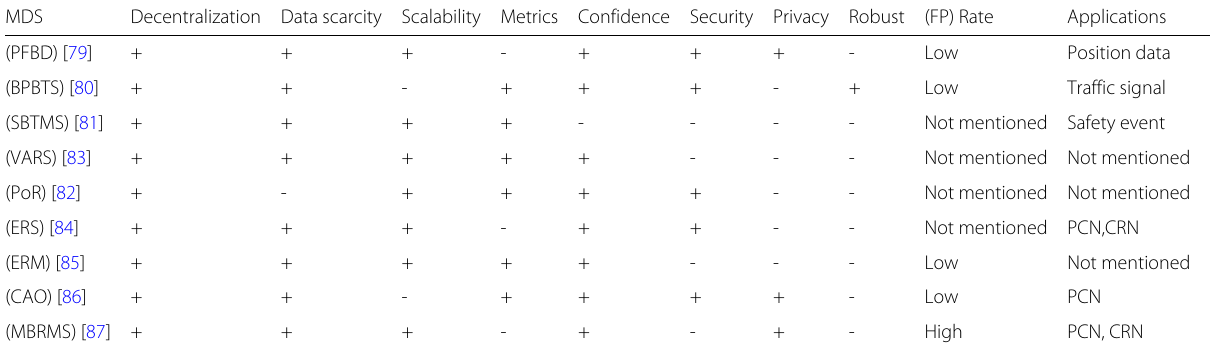
Table 3 Trusted based detection schemes